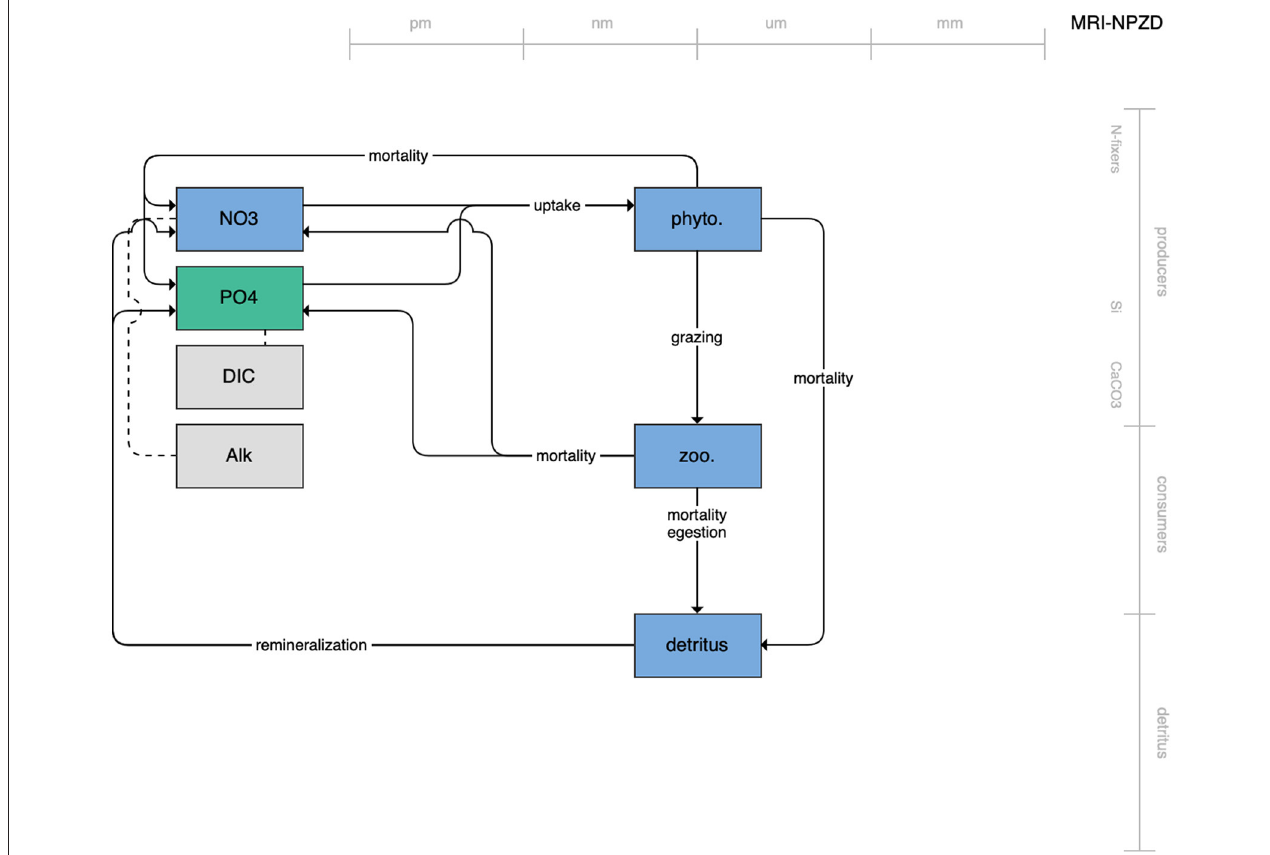
FIGURE 4 | Schematic for the MRI NPZD model. See Figure 1 caption for